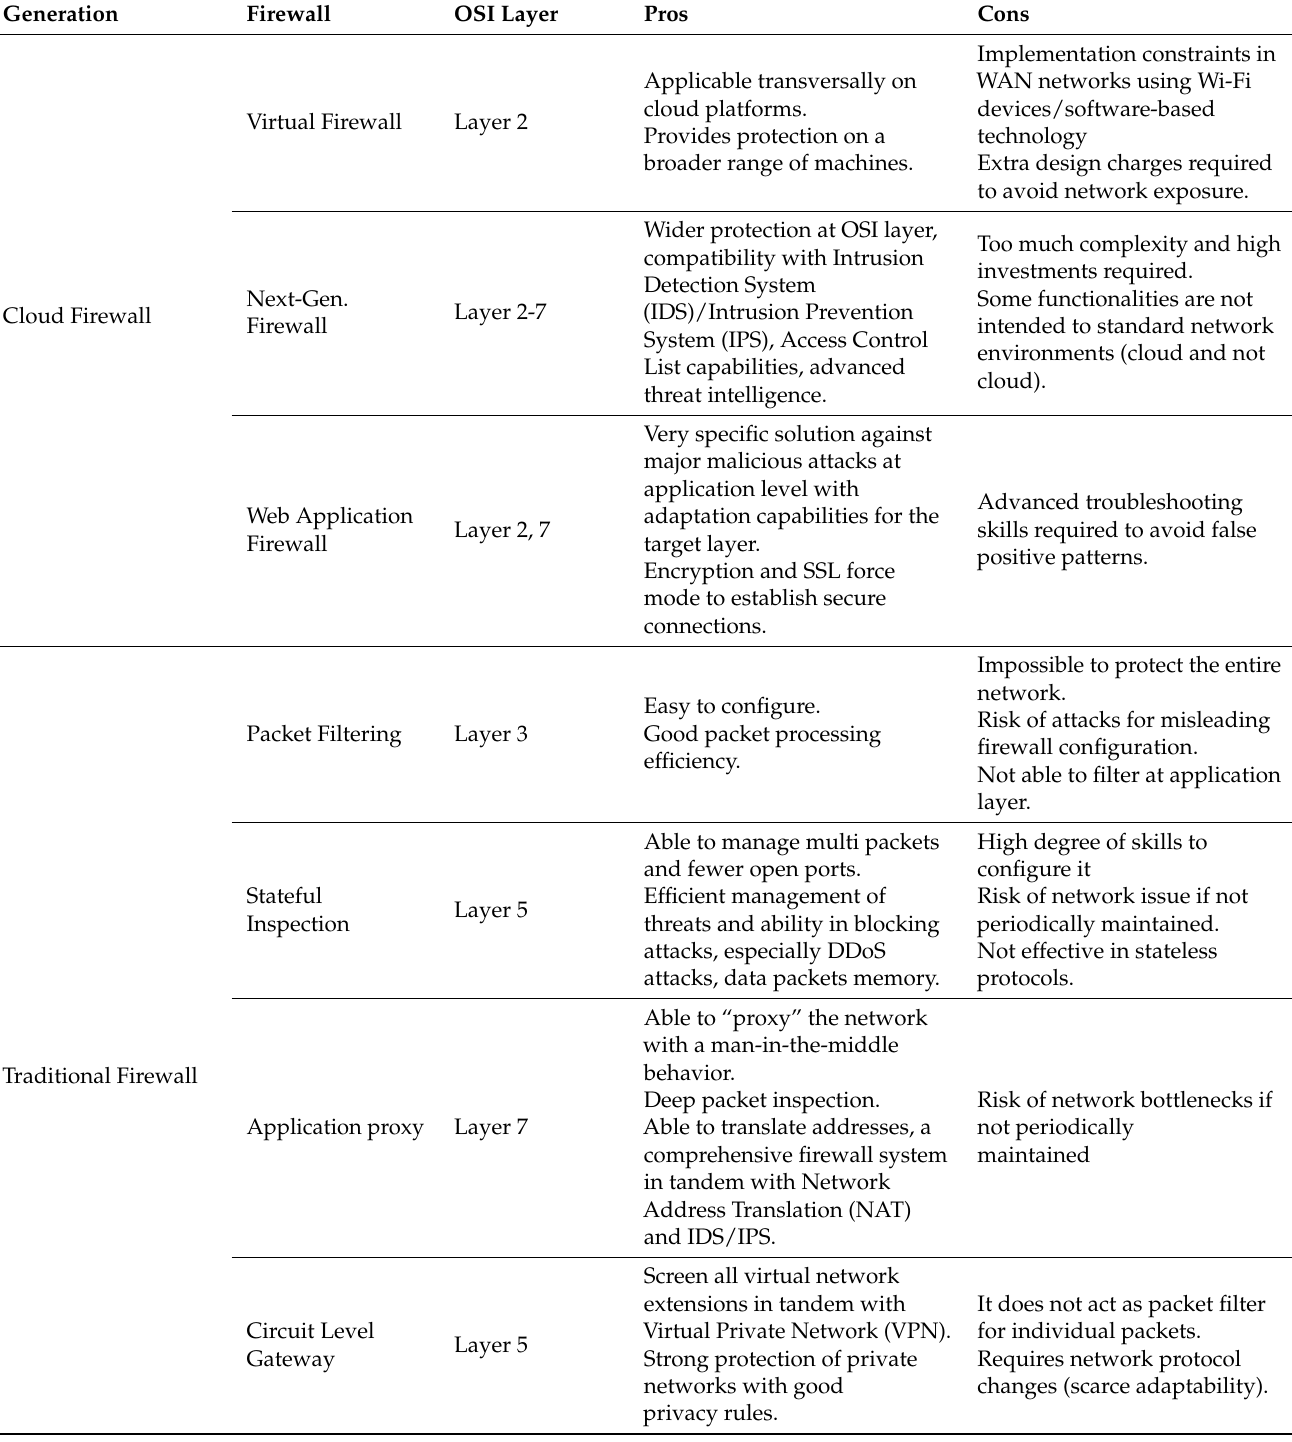
Table 1. Summary of firewall types and their evaluation with pros and